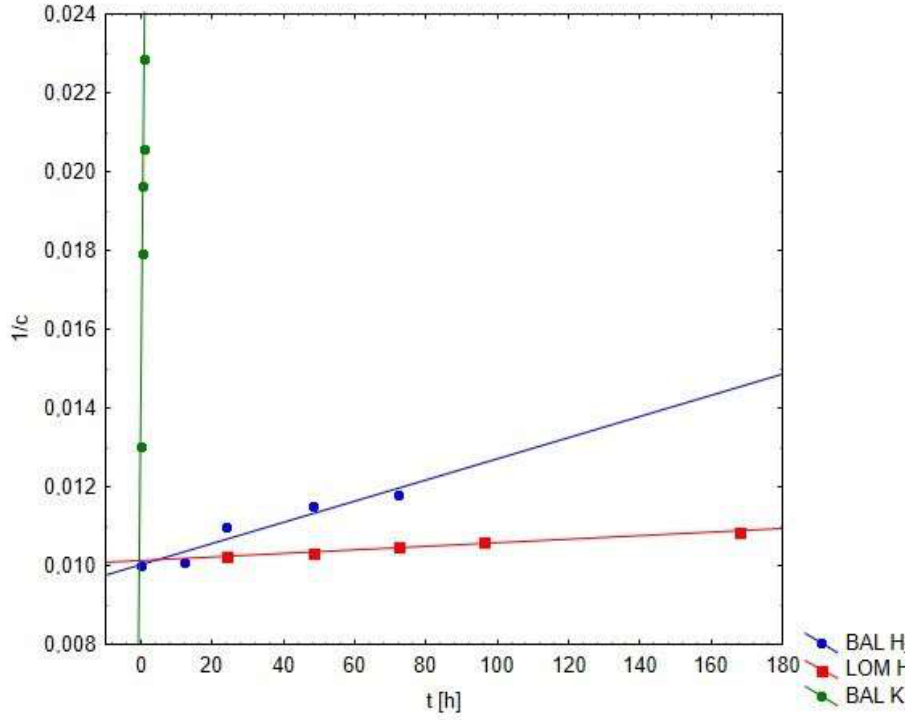
Figure 12. The 1/c = f(t) graph of oxidation of examined fluoroquinolones (FQs) by H 2 O 2 and BAL by KMnO 4 . Table 2. The kinetic results of the FQs oxidation by ACVA. Component